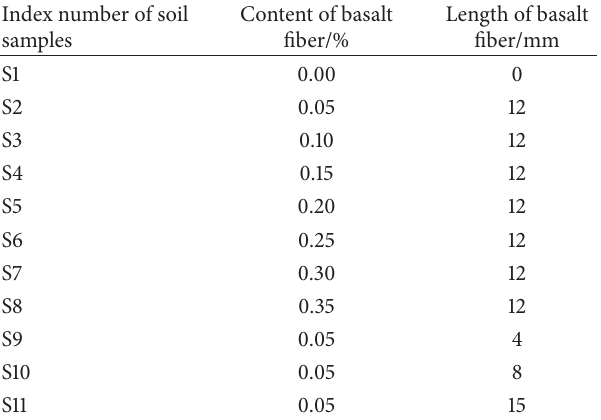
Table 3: Parameters of soil